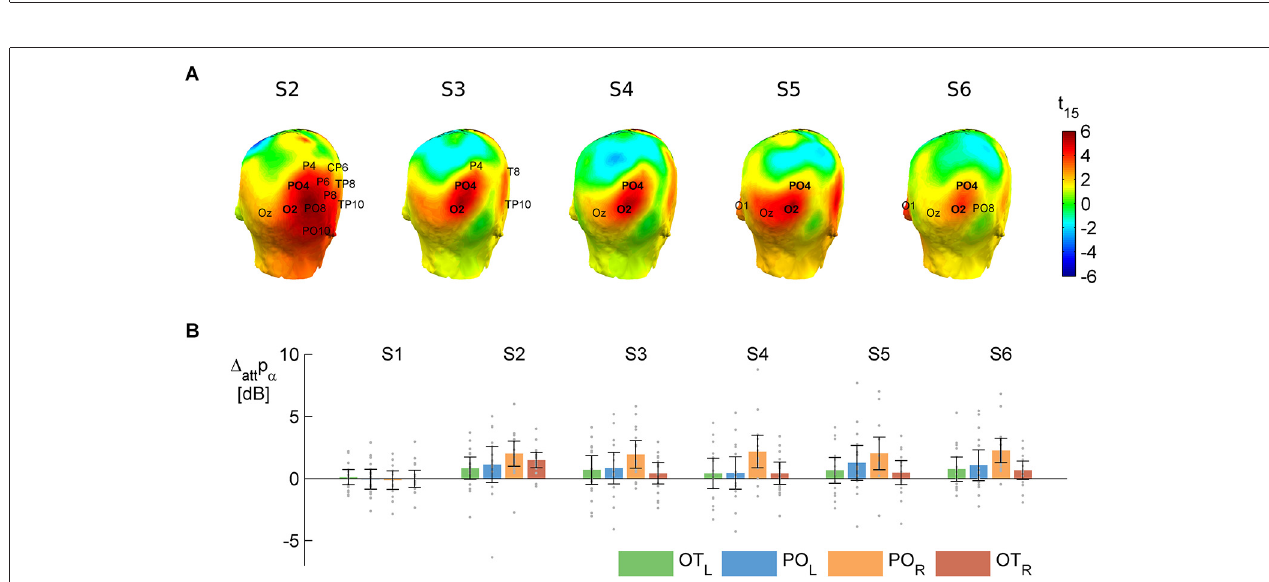
FIGURE 2 | Grand average alpha power over the left (POL: O1 and PO3) and right (POR: O2 and PO3) parieto-occipital cluster . The temporal evolution of alpha power in all four conditions is shown separately (solid and dashed thin lines for distractor absent and present conditions, respectively).